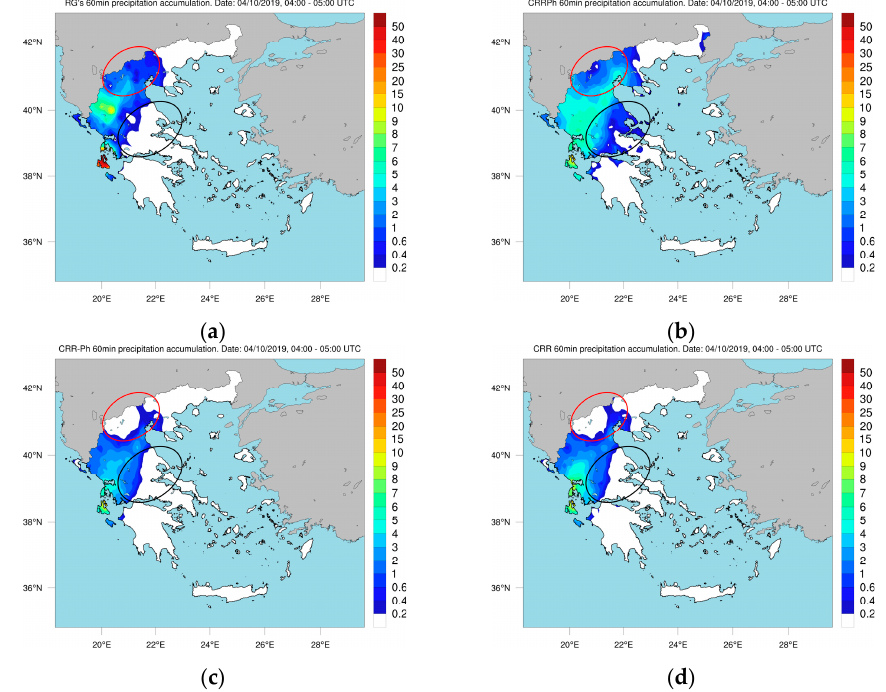
Figure 3. 04:00–05:00 UTC precipitation accumulations (in mm) for 4 October 2019, derived from ( a ) RG observations, ( b ) CRRPh v2021 estimations, ( c ) CRR-Ph v2018 estimations, and ( d ) CRR v2021 estimations.